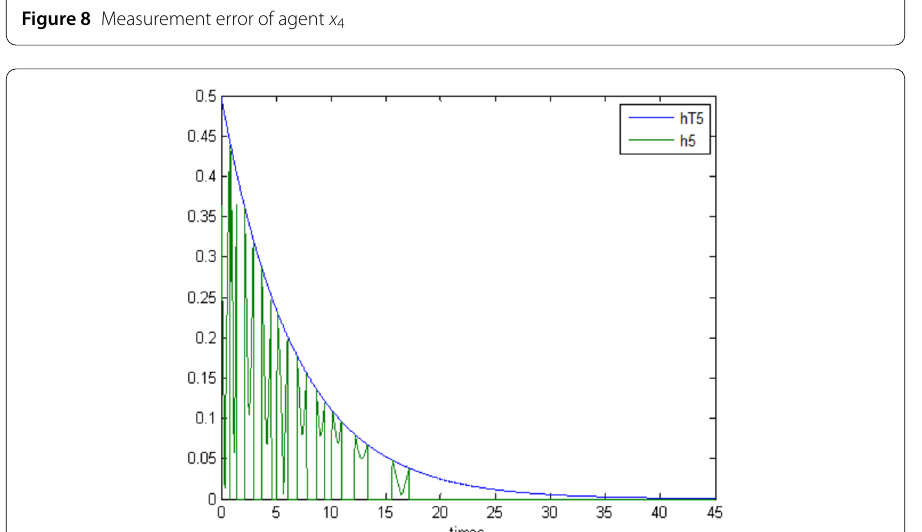
Figure 9 Measurement error of agent x